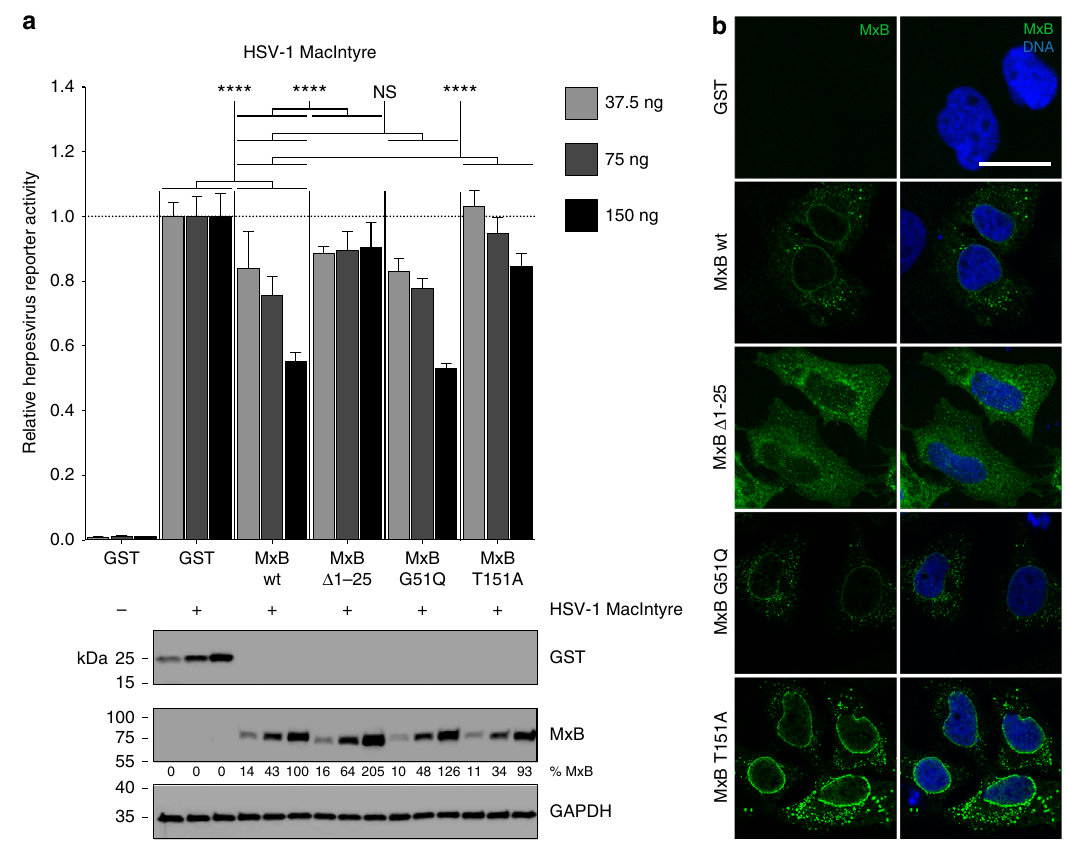
Fig. 7 HSV-1 restriction by MxB is speci fi ed by its amino terminus and requires GTPase function. a HeLa cells were transiently transfected with pGL-T9G reporter plasmid together with increasing amounts of expression plasmids encoding the indicated proteins. At 24 h post transfection, cells were mock- infected or infected with HSV-1 strain MacIntyre (MOI = 0.5). Virus infection ef fi ciency was determined by luciferase assay at 32 h post infection and is presented relative to the respective conditions with GST expression. Luciferase activity from all conditions is normalised to mock-infected cells. Data are representative of three independent experiments. Bars indicate mean ± s.d., n = 3 biological replicates. ANOVA modelling relative reporter activity with protein variant and dose as explanatory variables: protein variant, F (4,30) = 51.311, p < 0.0001; dose, F (2,30) = 29.844, p < 0.0001; synergistic interaction, F (8,30) = 6.407, p < 0.0001. Multiple comparisons: NS p ≥ 0.05; **** p < 0.0001. GST and MxB protein expression was controlled by immunoblot analysis using pooled samples for each condition. GAPDH served as loading control. b HeLa cells were transiently transfected with expression plasmids encoding the indicated proteins. At 24 h post transfection, cells were fi xed and MxB protein expression and intracellular localisation was assessed by immunostaining. Nuclei were stained with Hoechst 33342. Scale bar, 20 µ